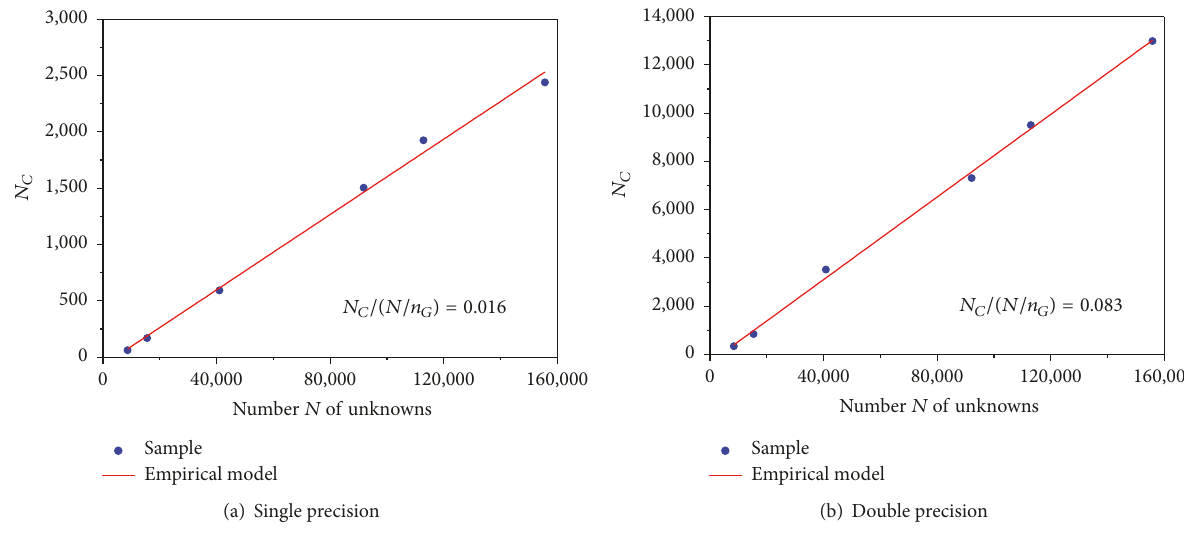
Figure 2: 𝑁 𝐶 as a function of N / 𝑛 𝐺 with 𝑛 𝐺 = 2